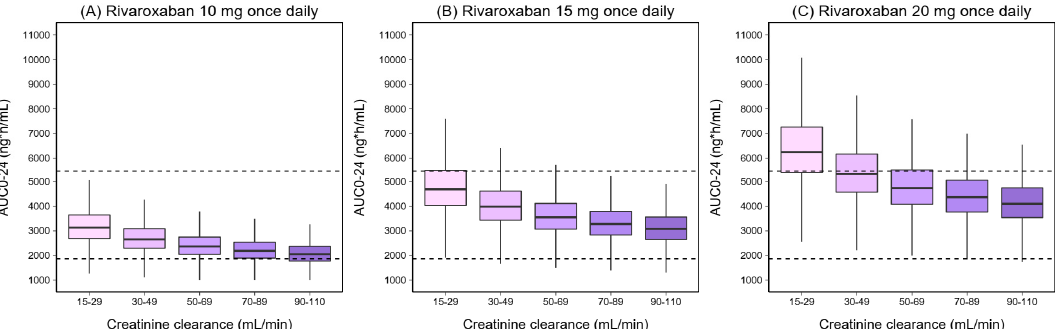
Figure 4. Simulated minimum concentration (C MIN ) of rivaroxaban with different dosing regimens. The boxplots represent the predicted C MIN stratified by creatinine clearance and body weight. ( A ) rivaroxaban 10 mg once daily. ( B ) rivaroxaban 15 mg once daily. ( C ) rivaroxaban 20 mg once daily. The dashed lines represent the 5th and 95th percentile ranges of the typical C MIN (12–137 ng/mL) reported in patients with non-valvular atrial fibrillation receiving 20 mg of rivaroxaban [19].